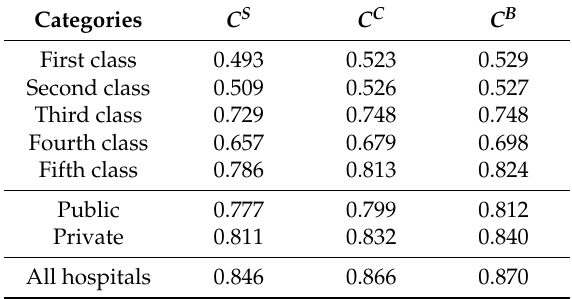
Table 2. Correlation values between street centralities and different categories of